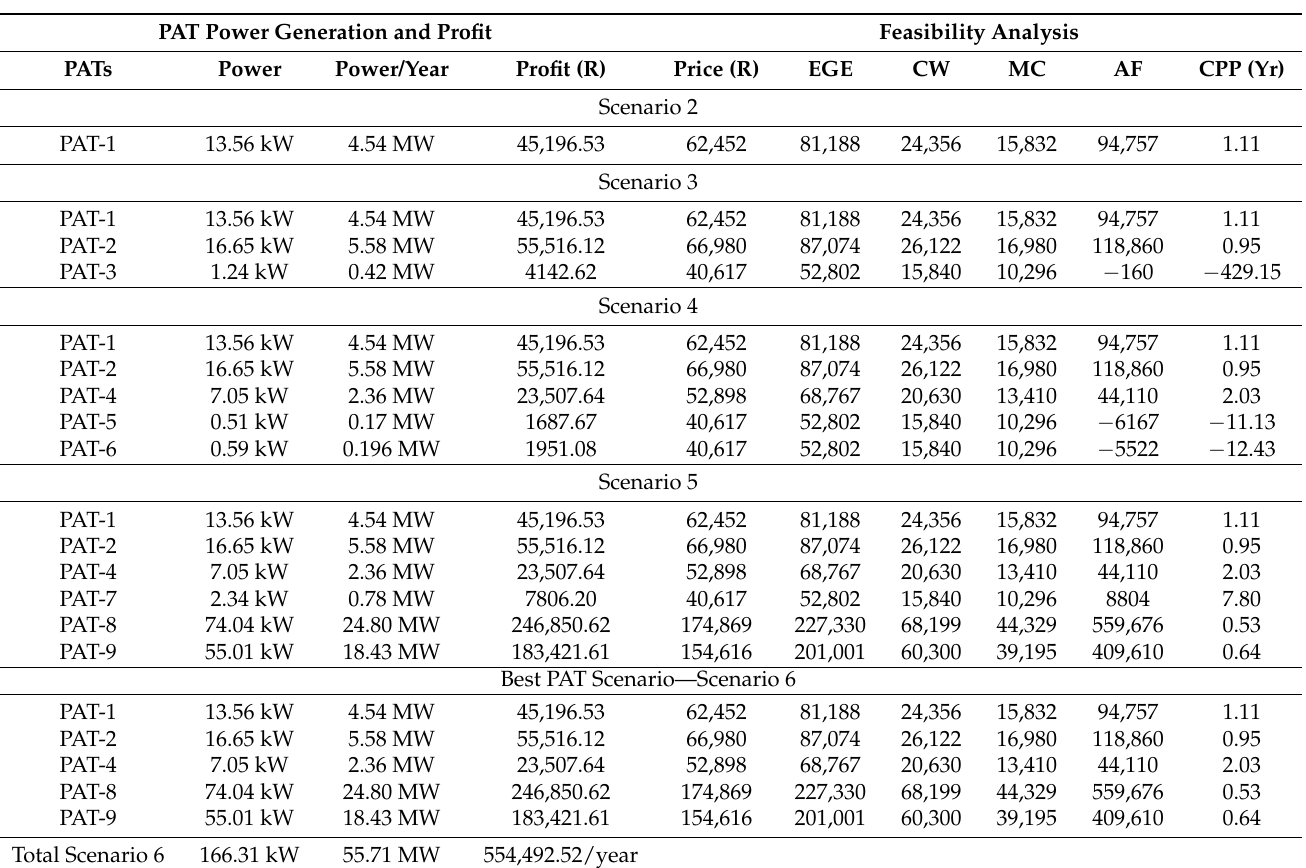
Table 3. PAT power generation and profit (per day and per year) and feasibility study for each PAT (1 ZAR (R) = USD 0.066 as on 12 February